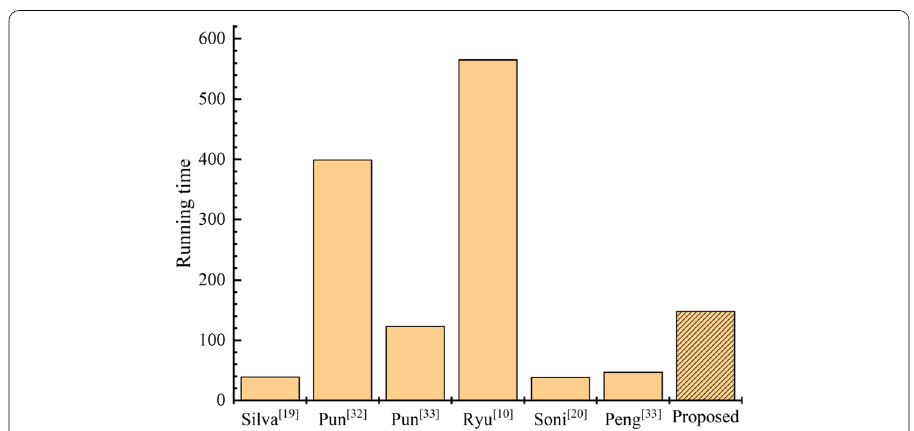
Fig. 13 Running time comparison of different